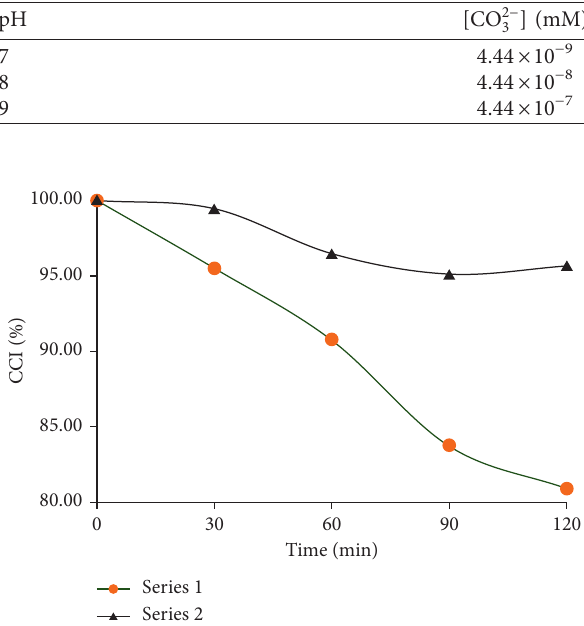
Figure 4: Effect of pH on calcium carbonate scale inhibition, as a function of time. Table 1: Effect of pH on carbonate concentration in 9.50mM bicarbonate solution.